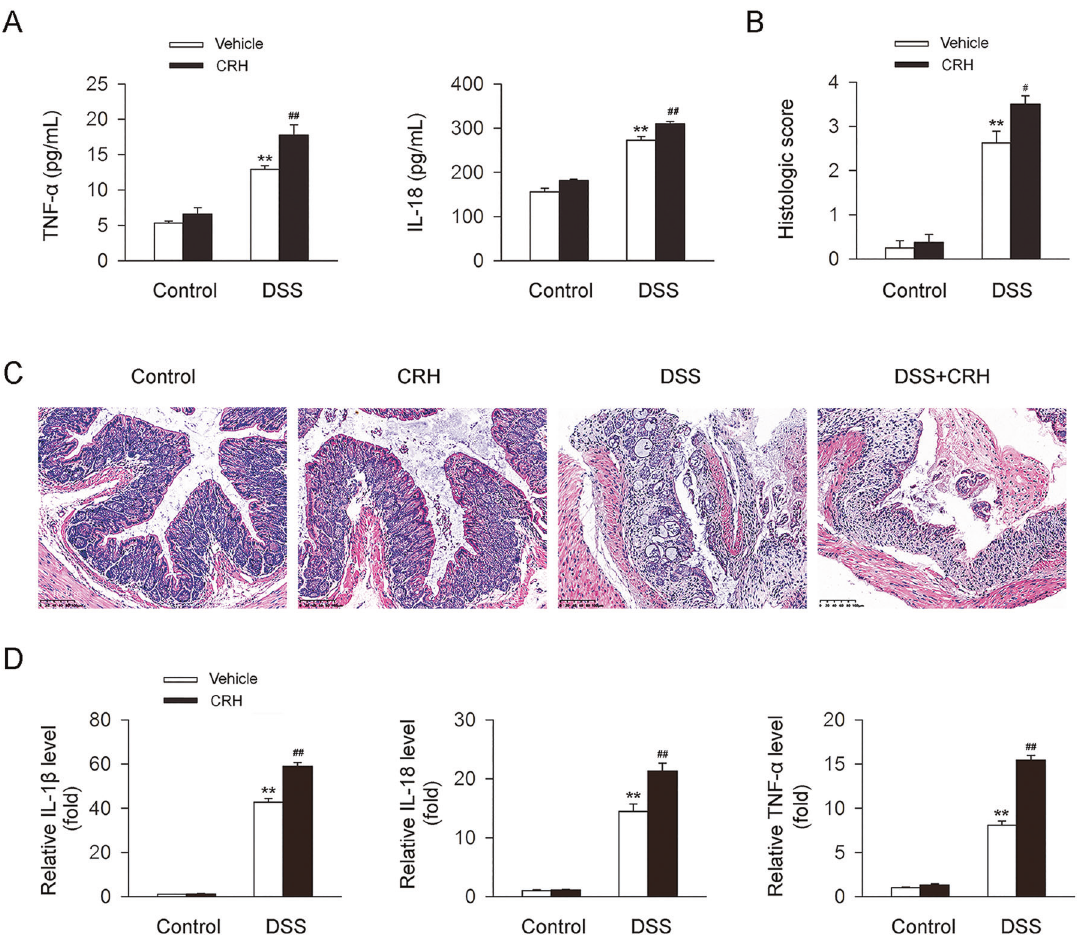
Fig. 2 CRH contributed to the increase of in fl ammation in IBD mice. C57BL/6 mice were administered DSS (3%) for 6 days (and a control group was provided with water only for comparison). For the CRH treatment group, CRH (or vehicle only) was intraperitoneally injected at a dose of 50 μ g/kg body weight from day 1 to day 6 using saline as the vehicle. A In comparison with the DSS + vehicle group, mice in the DSS + CRH group demonstrated increased levels of TNF- α and IL-18 in serum ( n = 6 per group). ** P < 0.01 vs. the control group; # P < 0.05 vs. the DSS + vehicle group; ## P < 0.01 vs. the DSS + vehicle group. B , C The left edge of the left colon was separated and fi xed, and then H&E staining was used for the detection of in fl ammatory in fi ltration (which was assessed using a histological score). In comparison with DSS- induced colitis mice, mice in the DSS + CRH group demonstrated a signi fi cant aggravation of in fl ammation in the left colon ( n = 8 per group). ** P < 0.01 vs. the control group; # P < 0.05 vs. the DSS + vehicle group. D IL-1 β , IL-18, and TNF- α mRNA levels in left colon tissues were analyzed by real-time qPCR. CRH administration also further enhanced levels of these proin fl ammatory factors in DSS-induced mice ( n = 6 per group). ** P < 0.01 vs. the control group; ## P < 0.01 vs. the DSS + vehicle